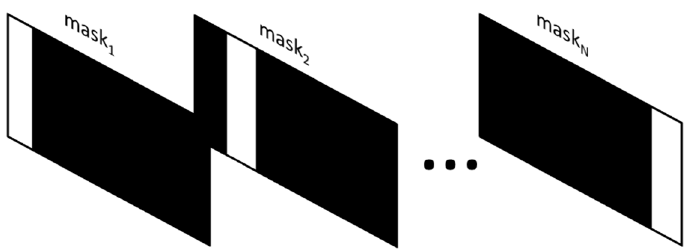
Figure 4. The sketch map of the single-stripe mode: in the single-stripe mode, only one column of micro-mirrors is turned on, corresponding to the single encoding matrix. The first detected light signal is reflected by mask 1 . Accordingly, the second detected light signal is reflected by mask 2 , and so on. After the last detected signal is detected with the reflection of mask N , the spectra can be de- rived.